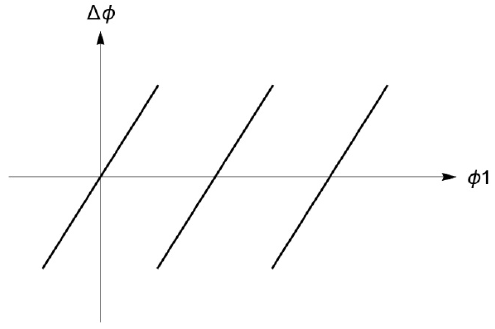
Figure 6. The function of TE with angular misalignment.